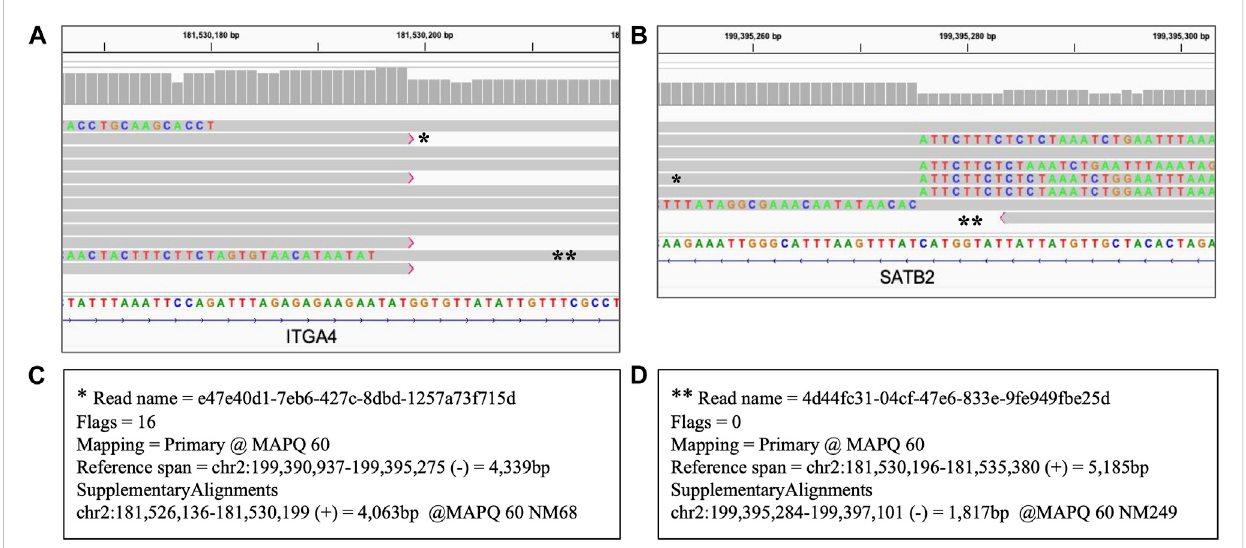
FIGURE 7 Heterozygous inversion of 17.86 Mb seq[GRCh38] inv(2) (q31.3q33.1). Long read WGS of Sample_9. Each thick gray horizontal line represents a separate read. String of letters below the panels indicate reference nucleotide sequence, and colored nucleotides over the read sequences stand for the nucleotides not matching the reference; strings of mismatches of that kind re fl ect the regions that got disjoined from the original reference location. Panels A and B represent two ends (breakpoint) of the same variant with the same reads partially mapping to the reference sequence at both ends separated by distance and orientation (i.e., split reads). Two examples of such split reads are marked with * and ** respectively. Panels C and D display primary and supplementary alignments for different reads, i.e., detached parts of the same read mapping with the best score and the second best score respectively to the different positions. (A) Left breakpoint alignment view; (B) Right breakpoint alignment view; (C) Alignment details of the reads marked with * in panels (A) and (B) . That read is mapped partially as a primary alignment at the left breakpoint coordinate and partially as a supplementary alignment in opposite orientation at the right breakpoint coordinate; (D) Alignment details of the read marked with ** in panels (A) and (B) . That read is mapped partially as primary alignment at the right breakpoint coordinate and partially as a supplementary alignment in opposite orientation at the left breakpoint coordinate.